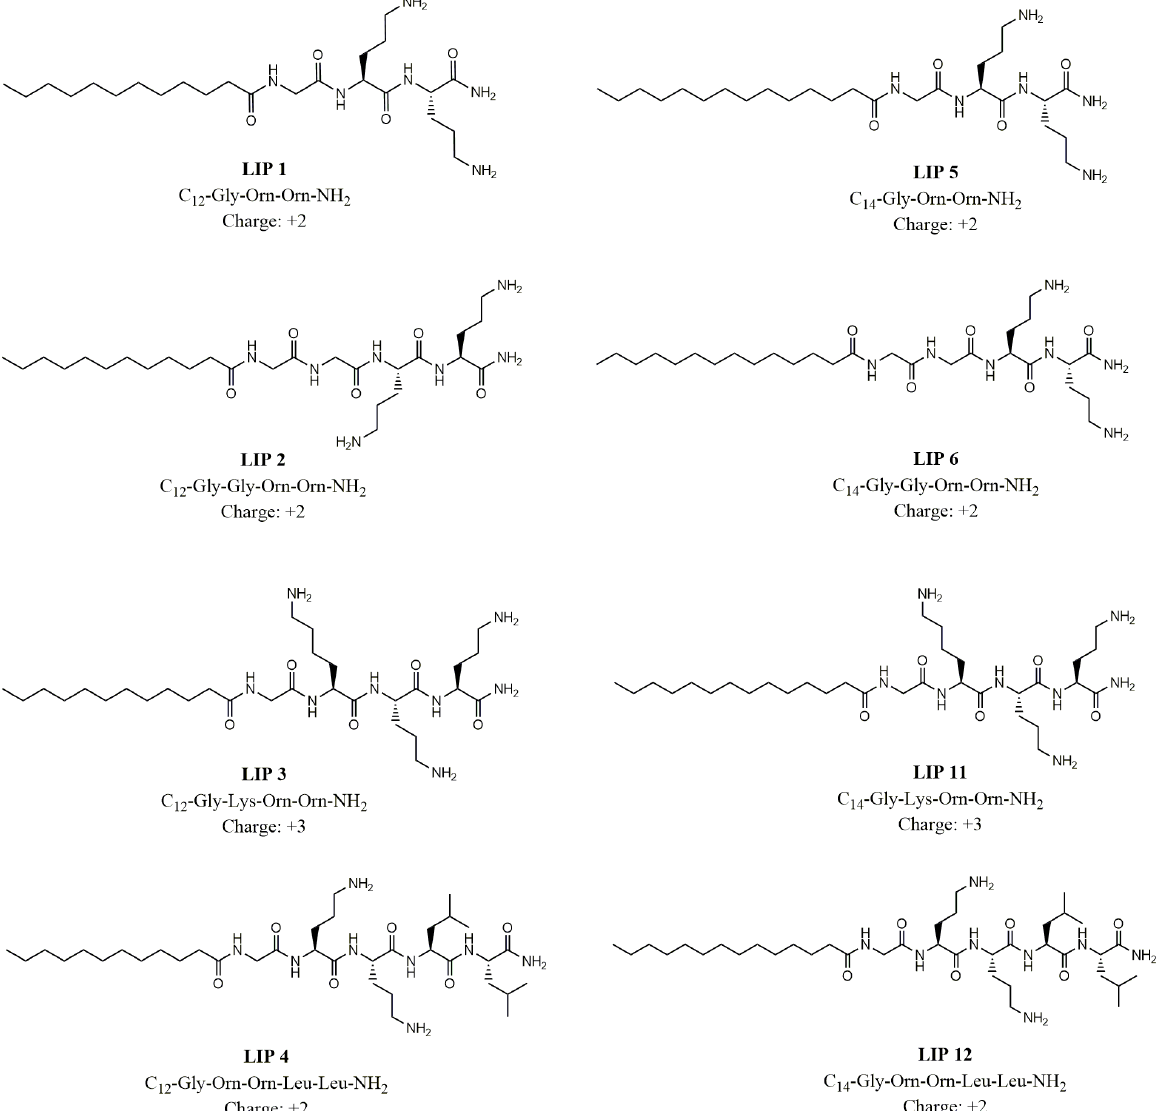
Figure 1. Molecular structures of the eight de novo designed